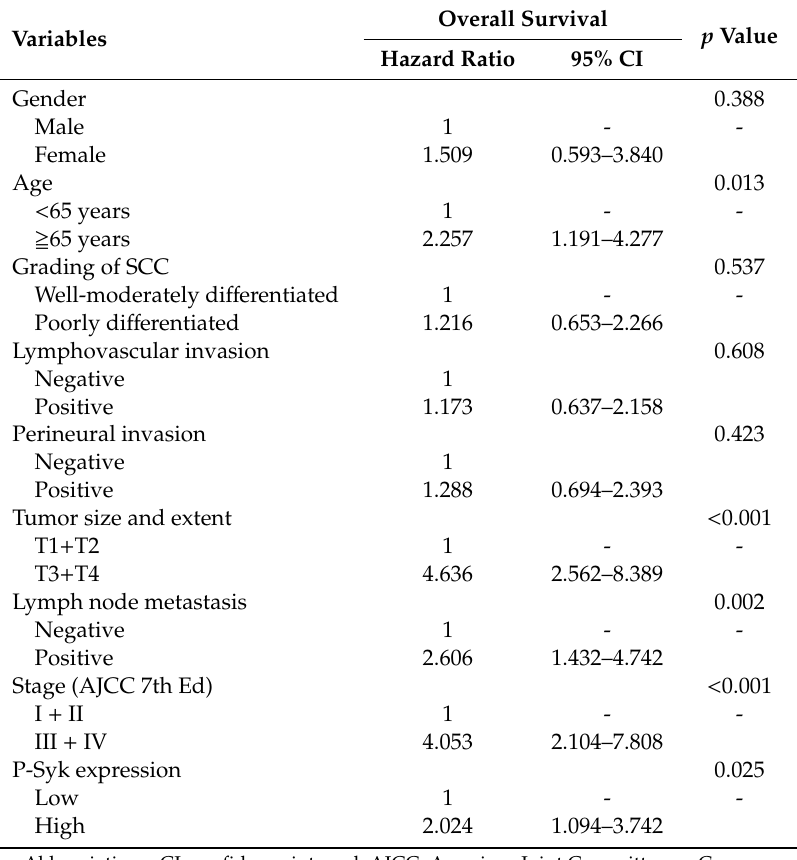
Univariate analysis of clinicopathological factors and p-Syk expression a ff ecting overall